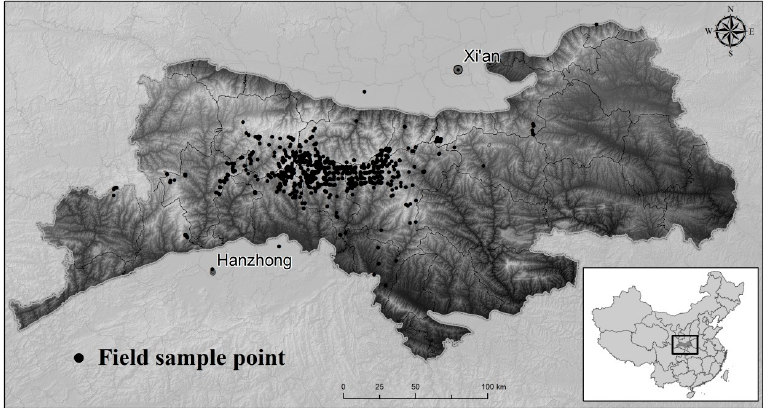
Figure 1. Spatial location of the Qinling Mountain region and survey sample points for biodiversity.